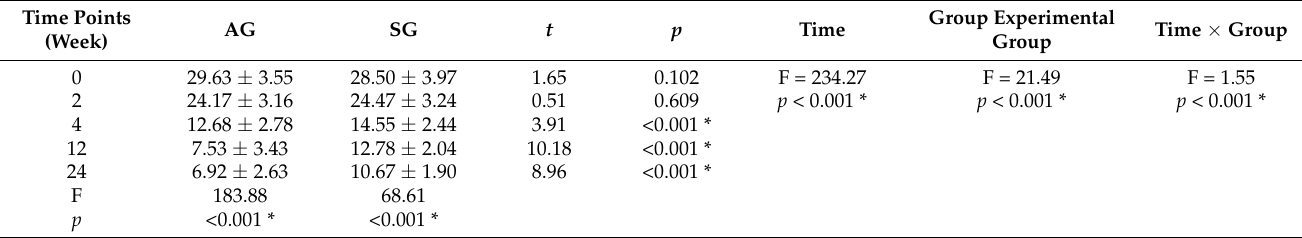
Table 2. Comparison of HAMD-17 scores between the two groups across the assessment time